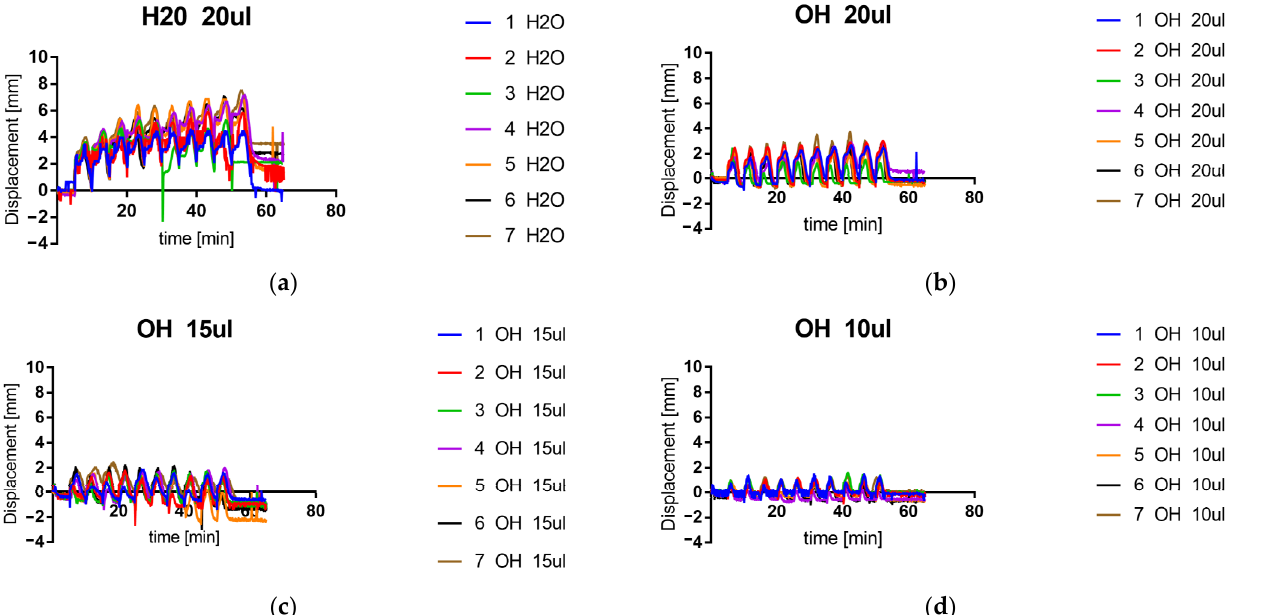
Figure 9. Measured displacement of each sample per amount of solution: ( a ) 20 μ L distilled water; ( b ) 20 μ L distilled water with alcohol (OH) ; ( c ) 15 μ L distilled water with alcohol (OH); ( d ) 10 μ L distilled water with alcohol (OH).